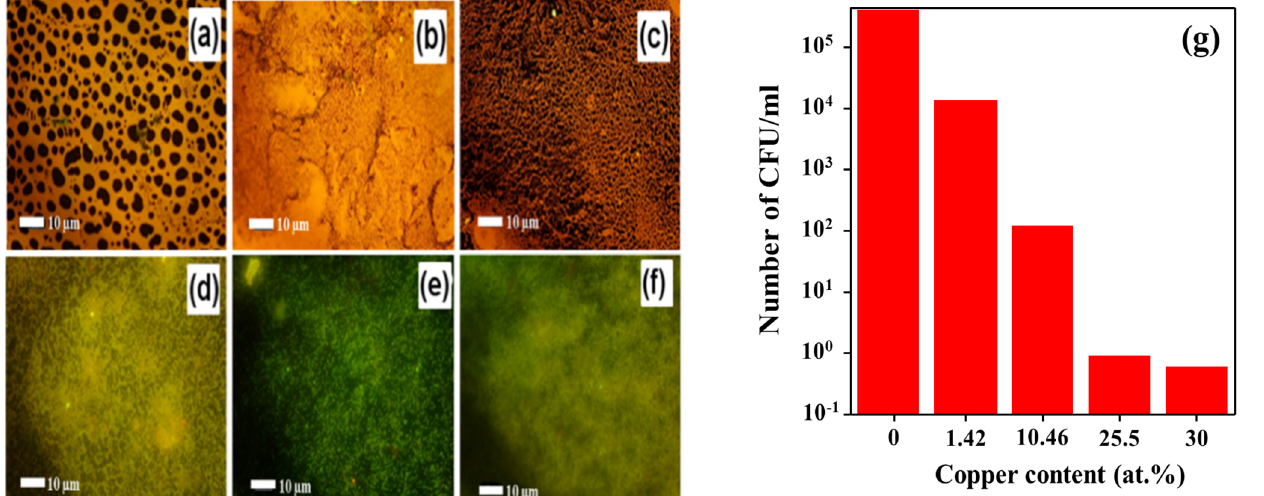
Figure 5. ( a – f ) Epifluorescence microscope images of TaN/Cu nanocomposite coatings with varying copper contents (at.%): ( a ) 0, ( b ) 1.42, ( c ) 10.46, ( d ) 25.54, ( e ) 30.04, and ( f ) 35. ( g ) Total viable count observed on TaN/Cu coatings with respect to changes in Cu content.